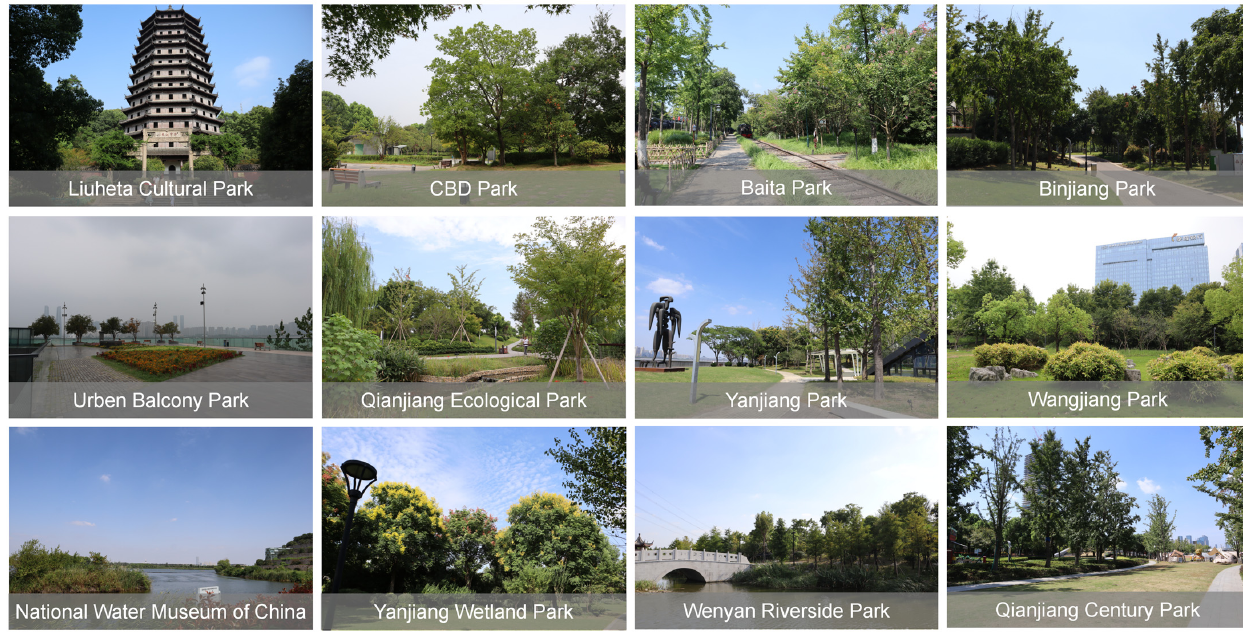
Figure 2. Present situation of waterfront parks.